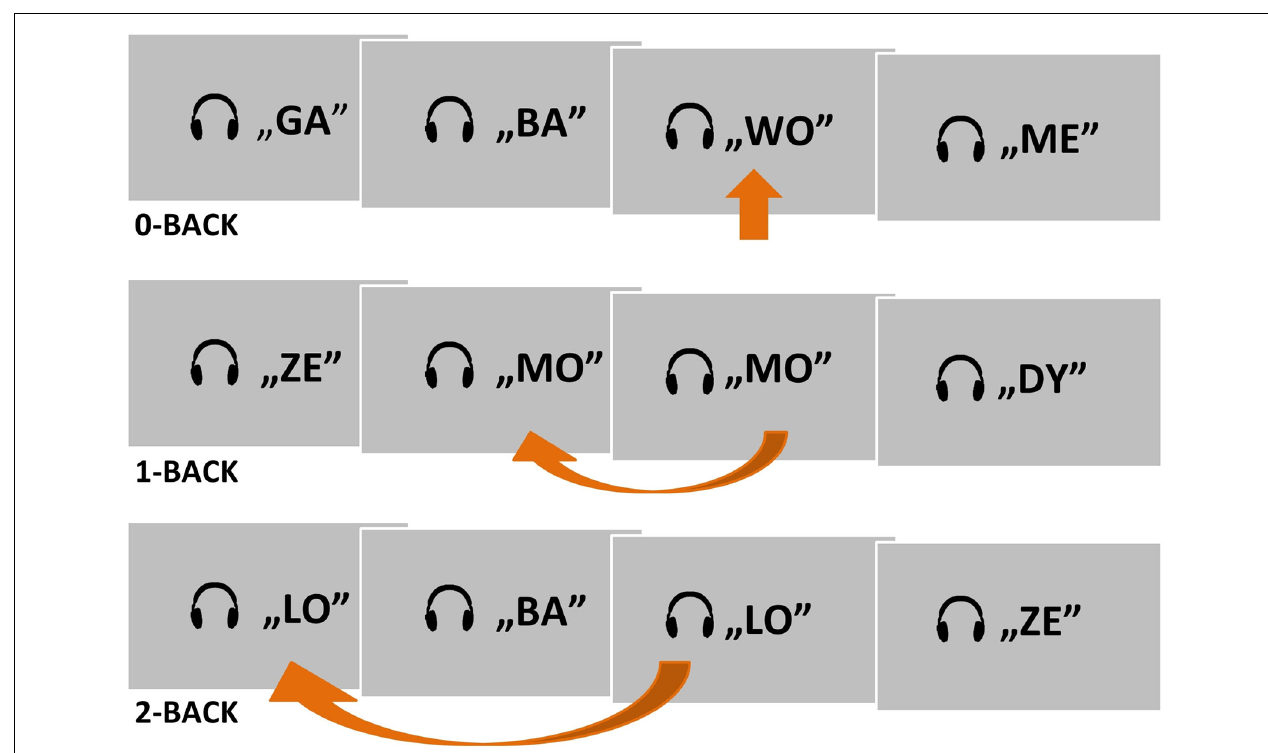
FIGURE 1 | A schema of the two experimental conditions (1- and 2-back) and one control condition (0-back) used in the auditory n -back fMRI task. Target situations are indicated by